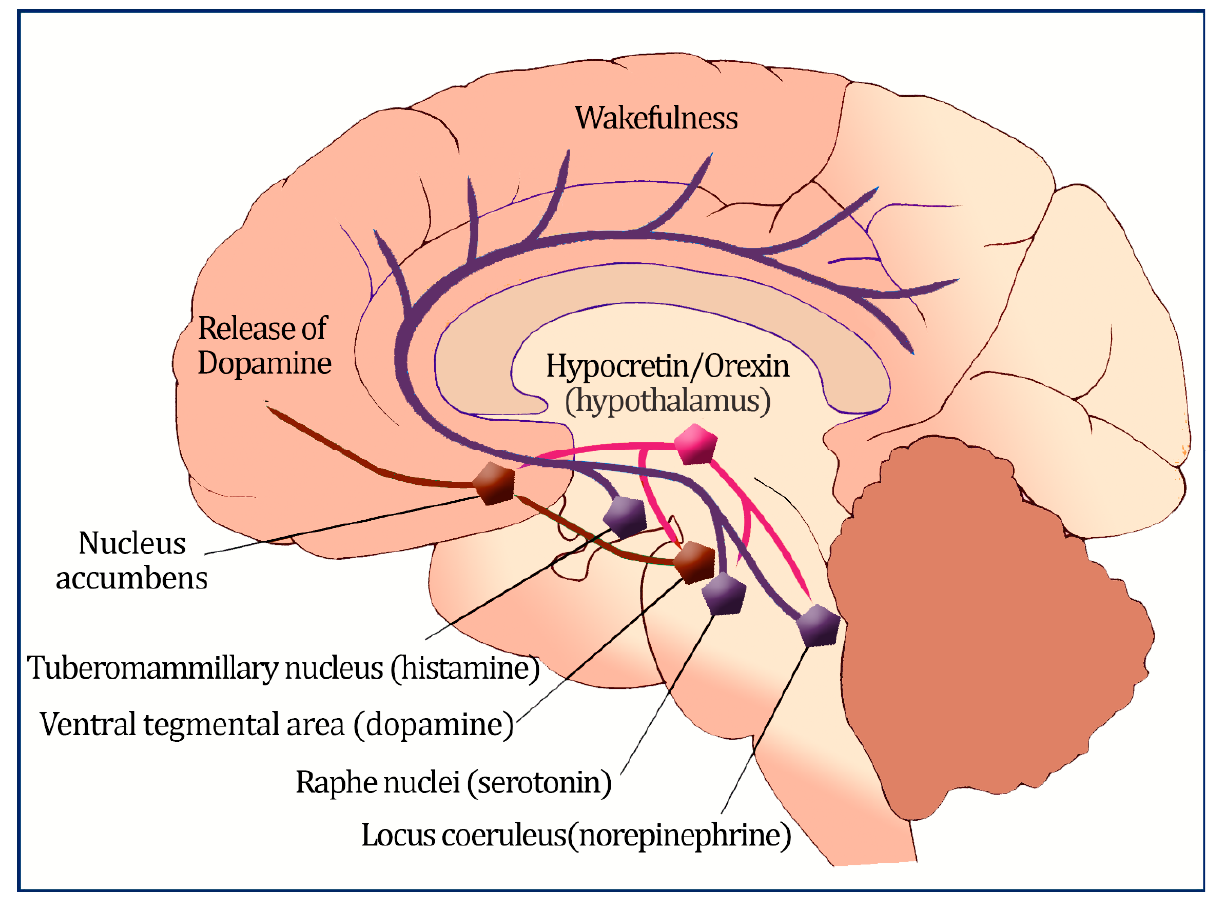
Figure 1. An illustration of the primary orexin neuron projections; orexin neurons located in the lateral and posterior hypothalamus regulate sleep and wakefulness by sending excitatory projections to the monoaminergic and cholinergic nuclei in the brain stem, and hypothalamic regions such as the locus ceruleus, the tuberomammillary nucleus, and the raphe nuclei.